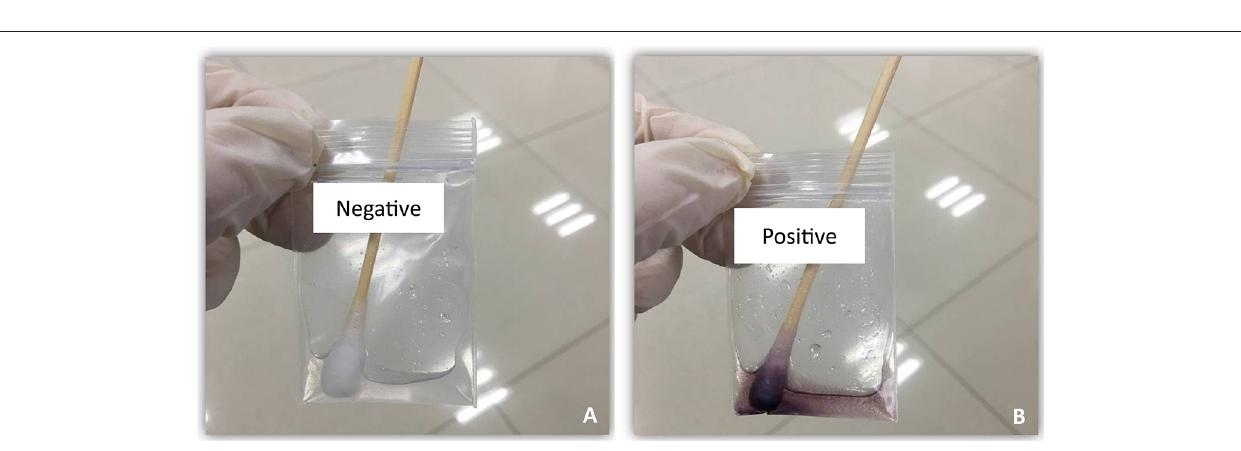
FIGURE 2 | Starch indicator for negative (A) or positive (B)